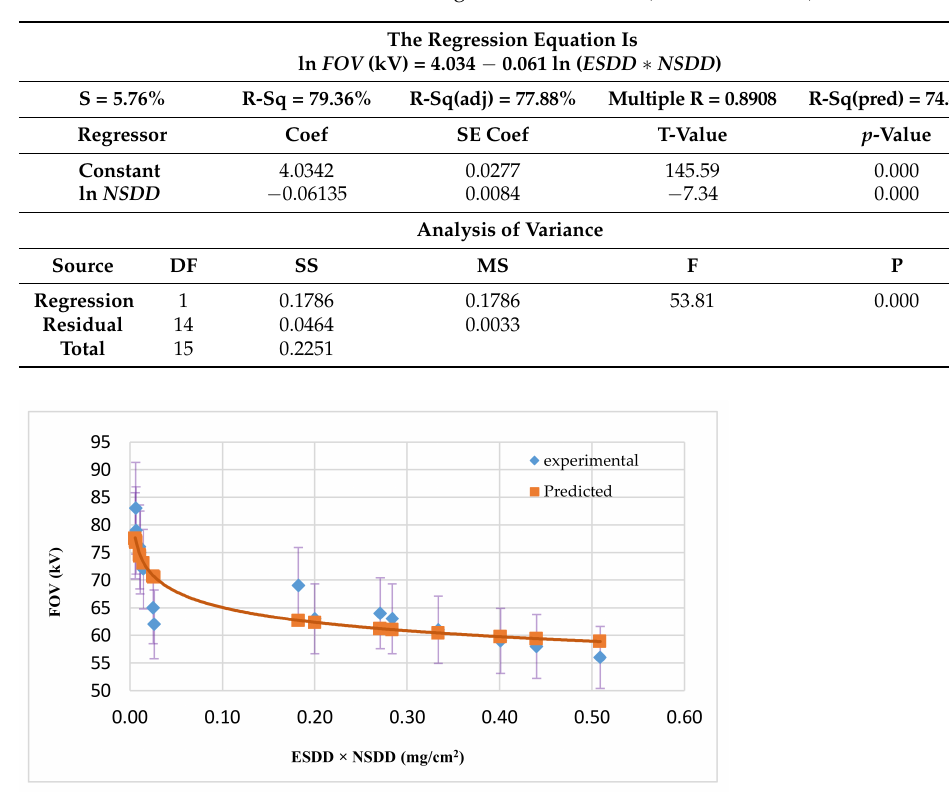
Table 4. Statistical results of Flashover voltage model based on ( ESDD × NSDD ).